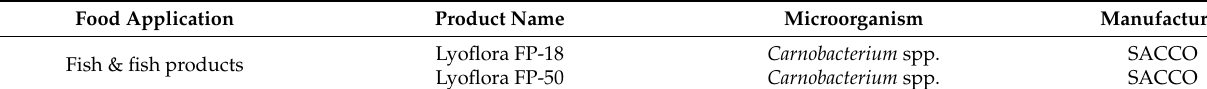
Table 4. Commercially available protective microbial cultures for various